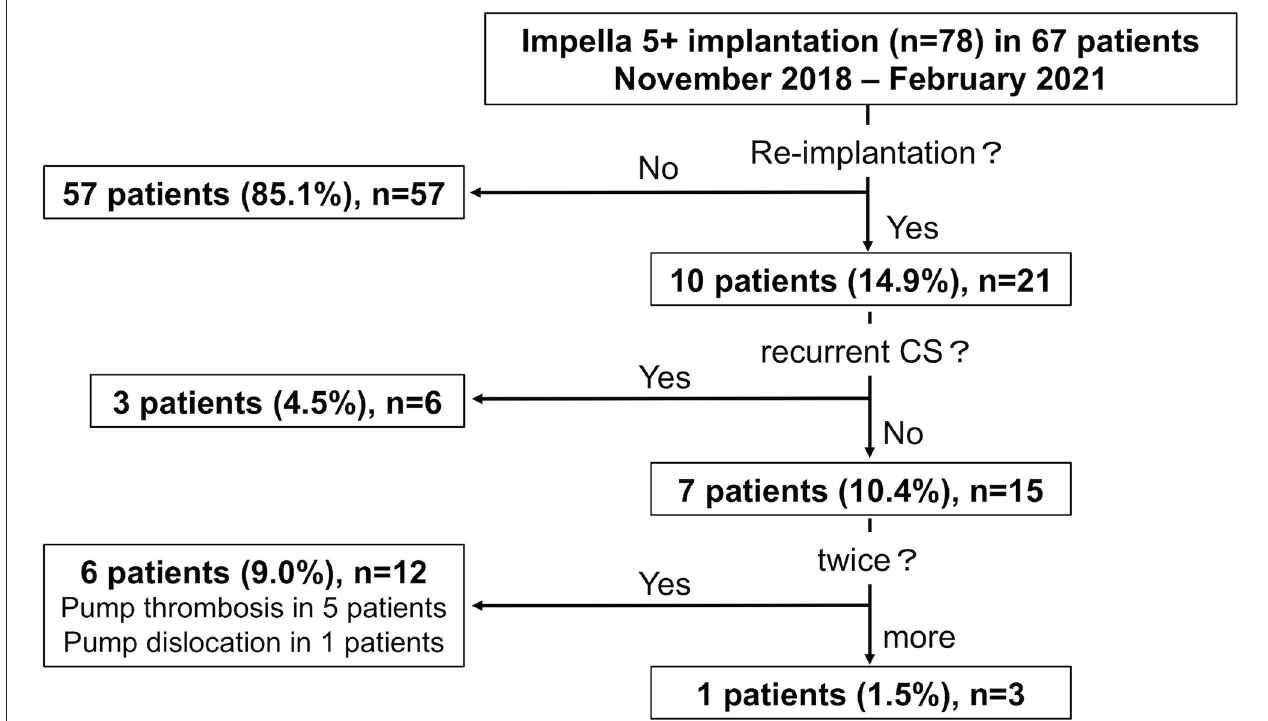
FIGURE 1 | The graphic flow chart of study population. Seventy-eight Impella 5 + (5.0 or 5.5) implantation in 67 patients. CS, cardiogenic